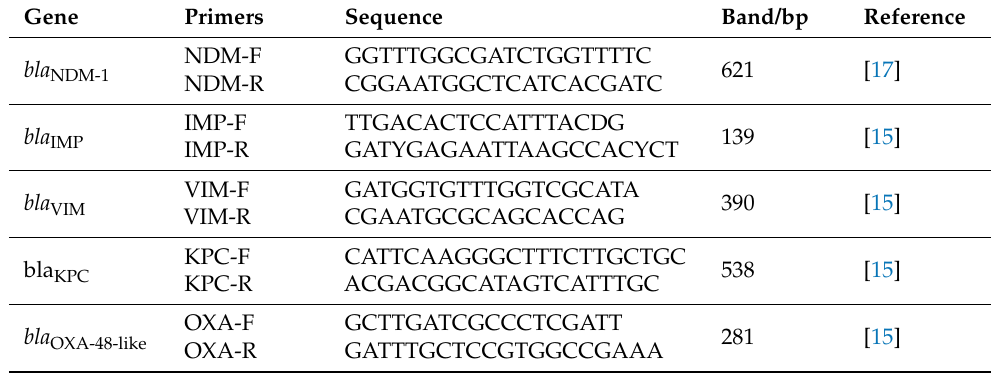
Table 1. Oligonucleotides used in this study.